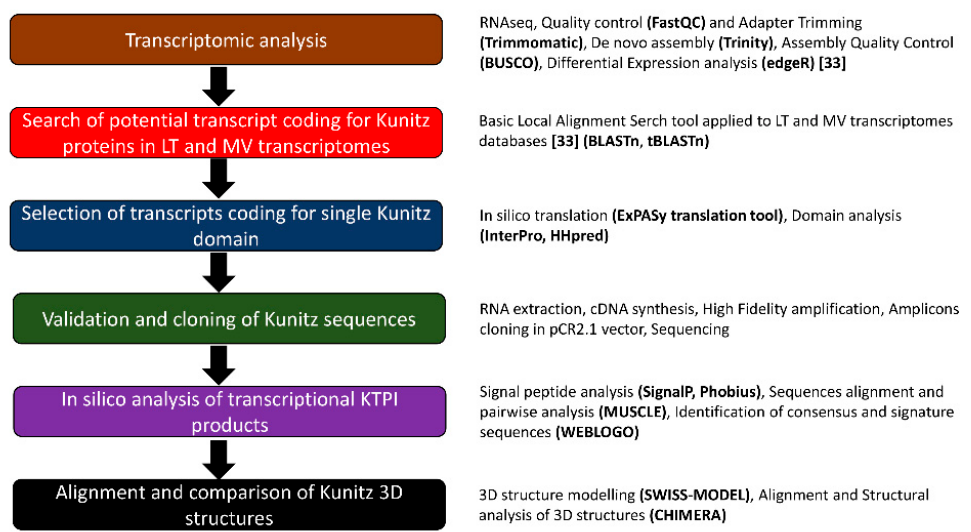
Figure 2. Workflow of the experimental strategy adopted in this study.